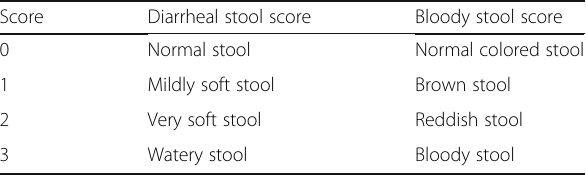
Table 2 Disease activity index (DAI) scoring system. The score was determined based on the characteristics of two stool types, and the sum of the scores of two parameters was defined as the DAI